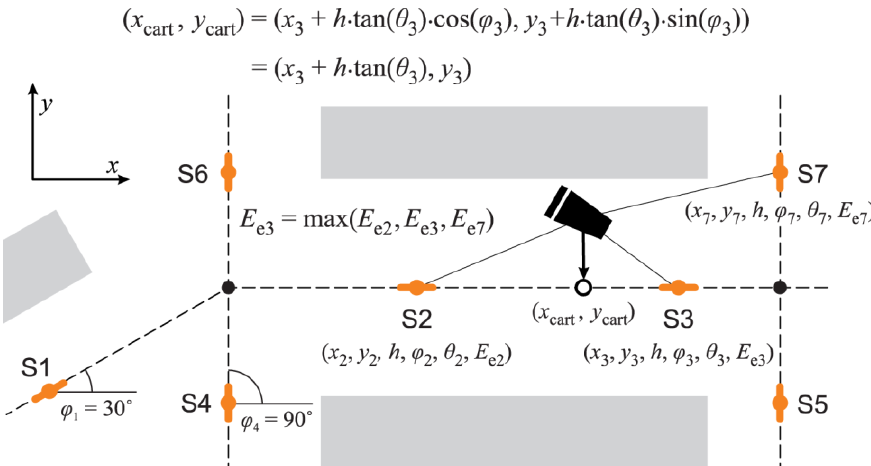
Figure 10. Sensing nodes S1–S7 are placed on the edges of the aisles graph (dashed line). After the IR transmission from the cart took place, nodes S2, S3, and S7 performed measurement and AoA estimation. Measured irradiance on the node S3 was the highest so the cart was localized using estimated AoA θ 3 and the position of the sensing node S3 in the Equation (1). The orientation of the node S3 is ϕ 3 = 0 ◦ ; thus, the estimated location is ( x 3 + h · tan ( θ 3 ) , y 3